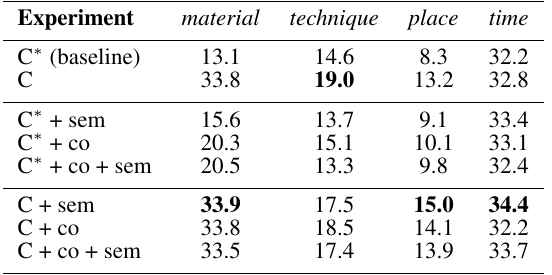
Table 5. Average F1-scores [%] over the m minority classes per variable, achieved in three